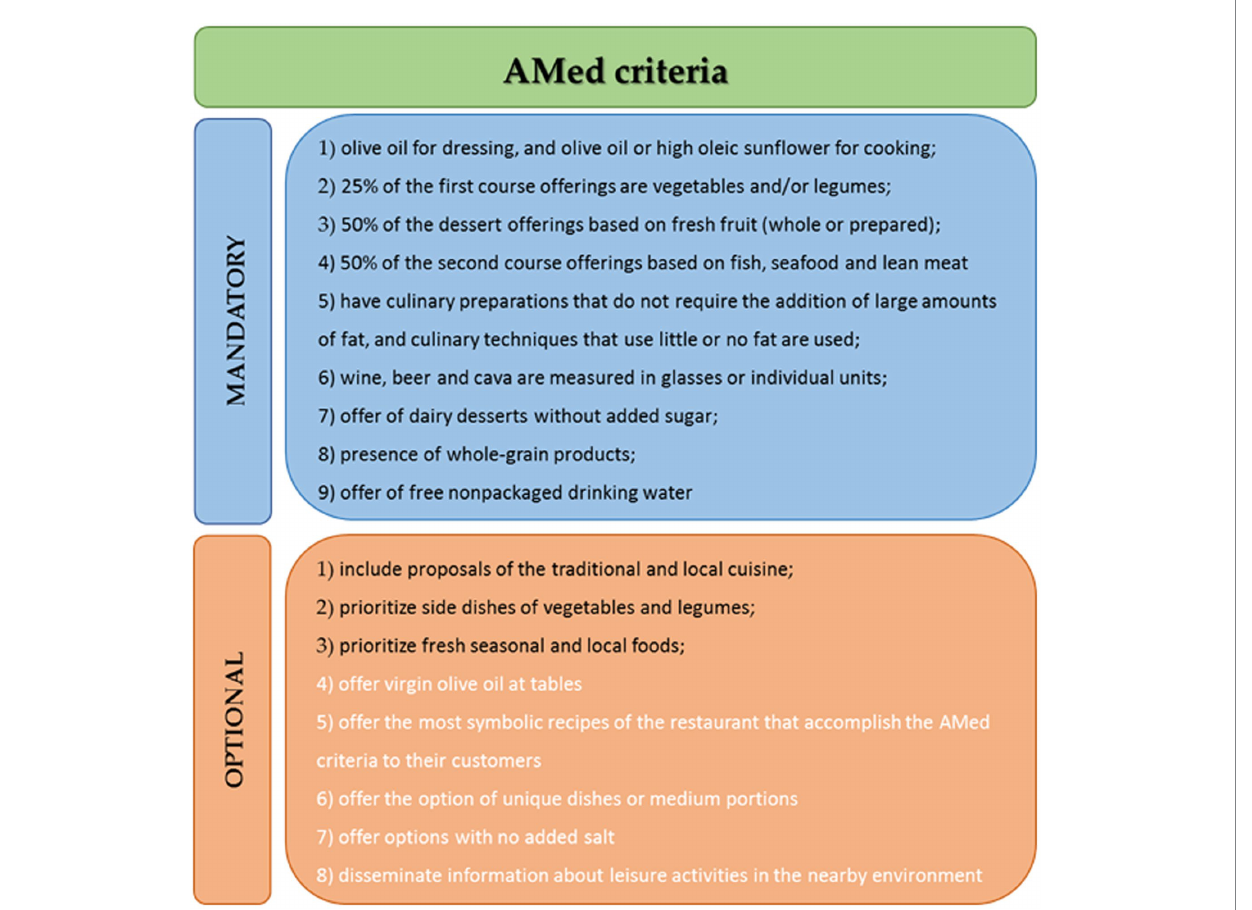
FIGURE 1 AMed criteria. The black quotes were the included in the analysis, and the white quotes were